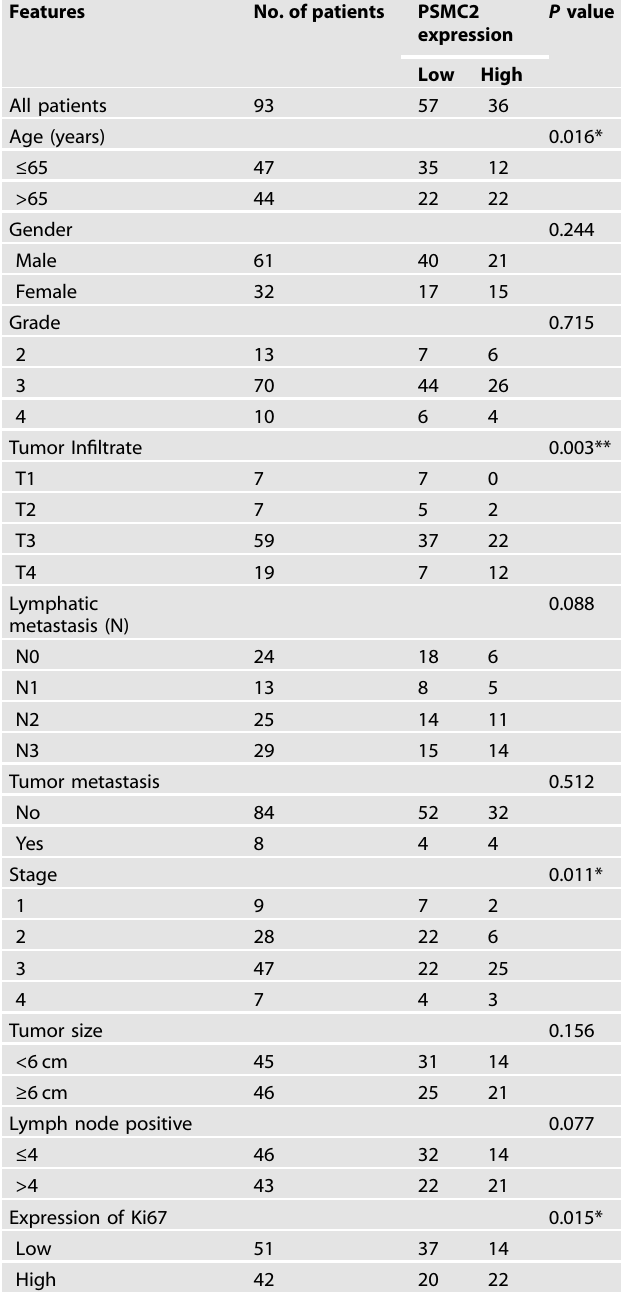
Table 2. Relationship between PSMC2 expression and tumor characteristics in patients with gastric cancer.